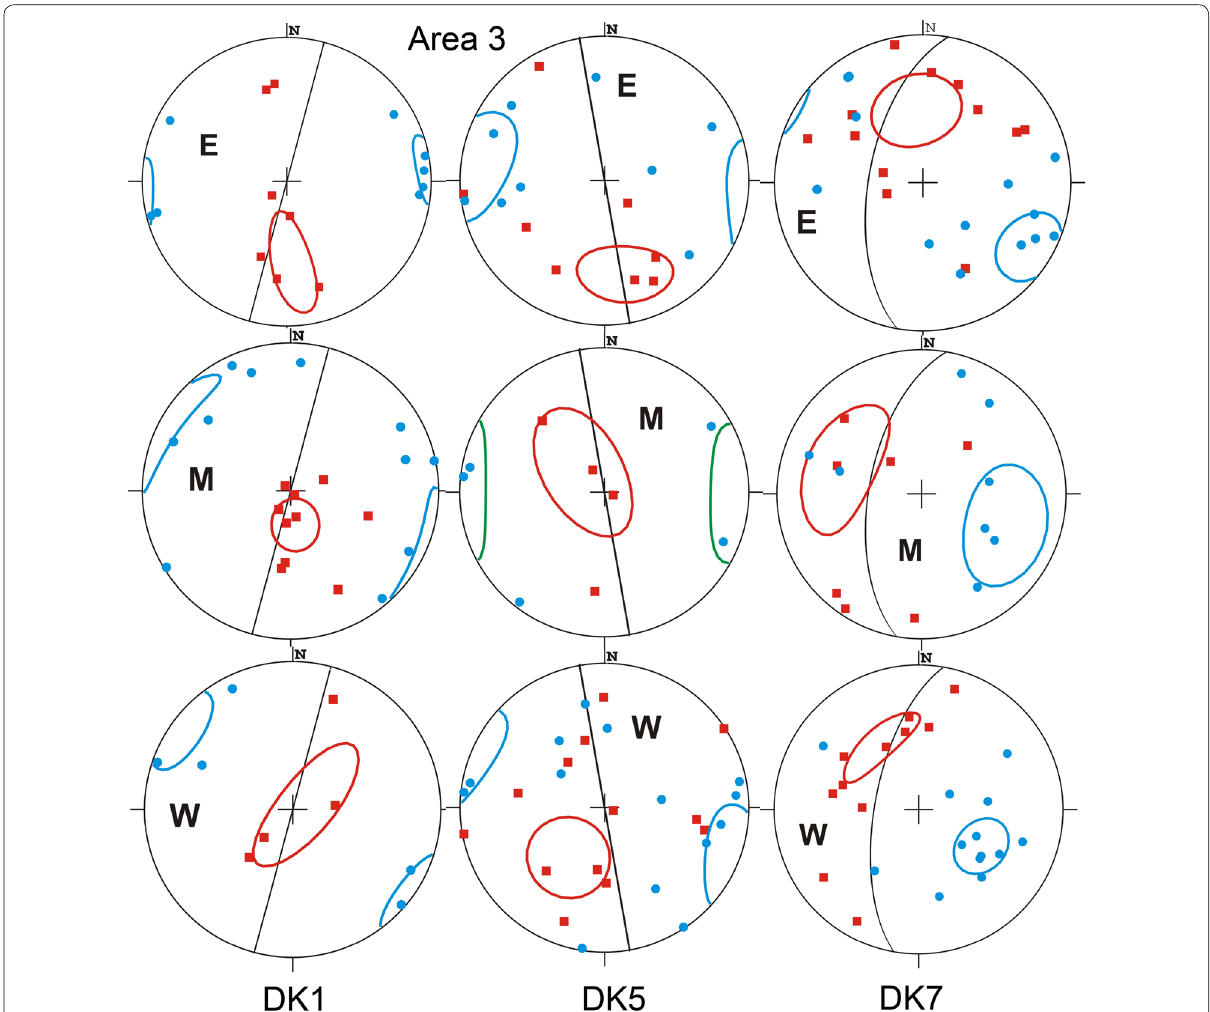
Fig. 10 AMS stereoplots for dikes DK1, DK5 and DK7 (Area 3). Same symbols as indicated in Fig. 8. M middle part of the